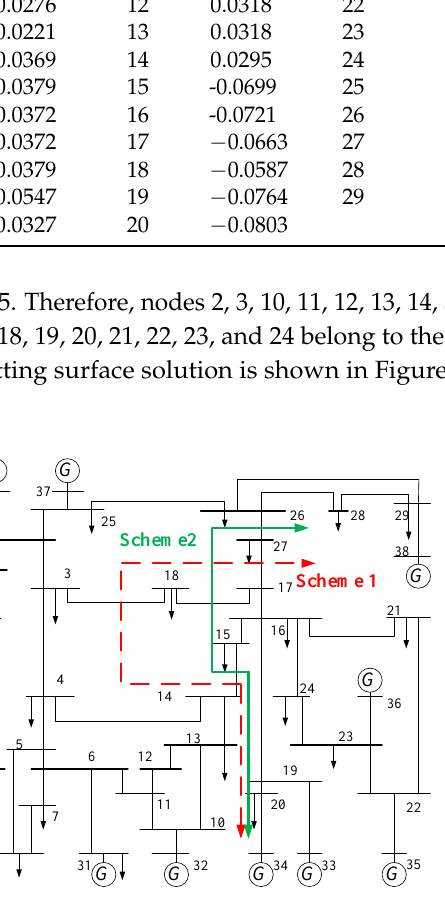
Table 3. Difference of the minimum edge weights cumulative summation.